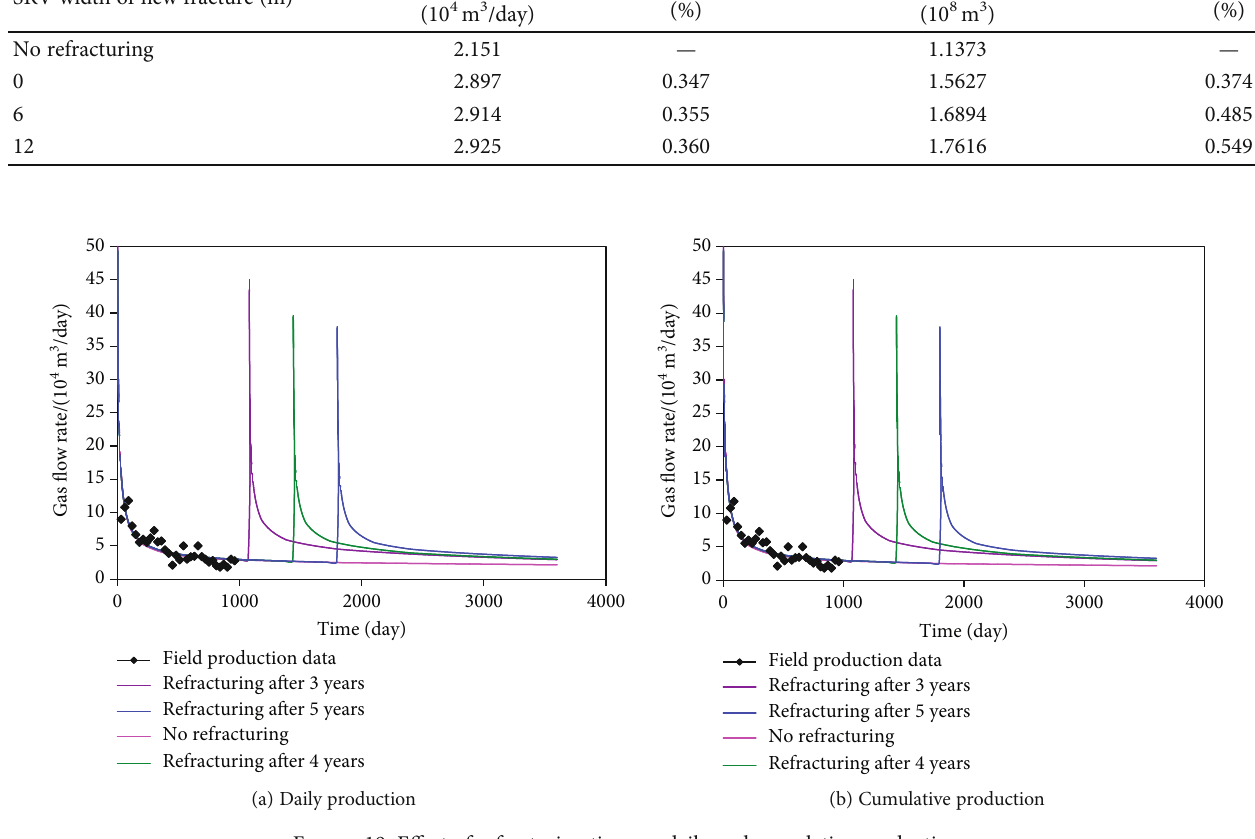
Figure 19: E ff ect of refracturing time on daily and cumulative productions. Table 9: Production increase percentage corresponding to di ff erent refracturing